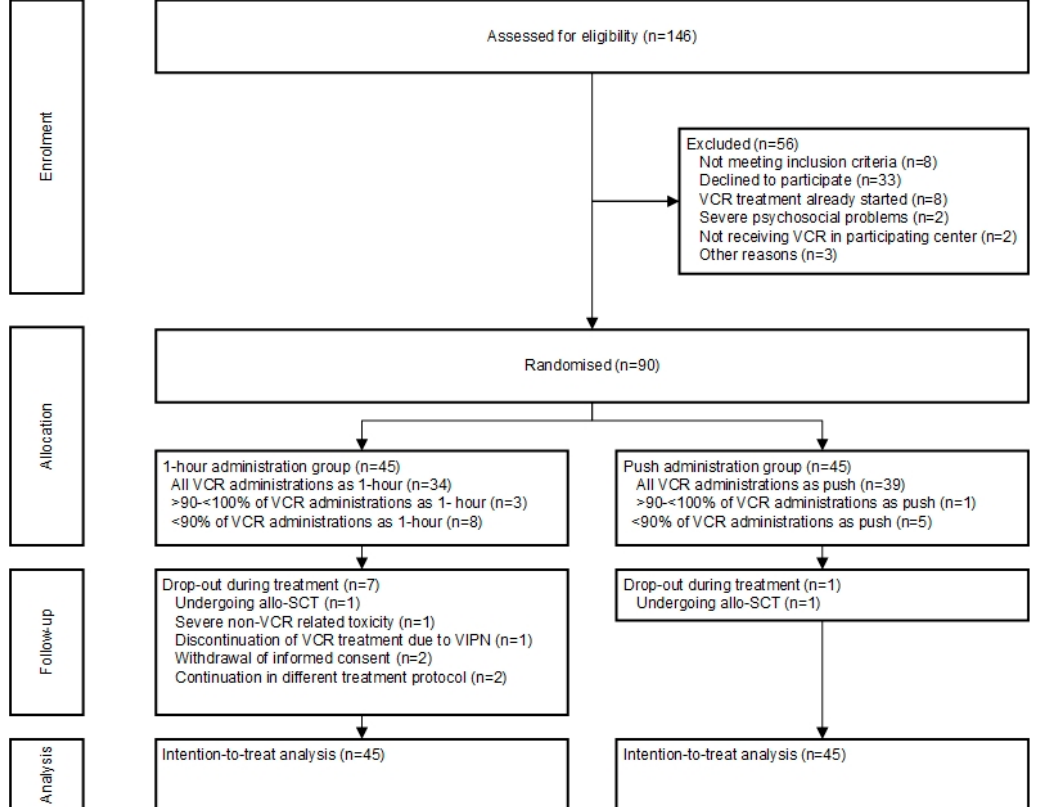
Figure 1. Flow diagram of screening, randomization, and follow-up. VCR: vincristine; allo-SCT: allogeneic stem-cell transplantation. Table 1. Demographic and clinical characteristics of the participants at baseline.